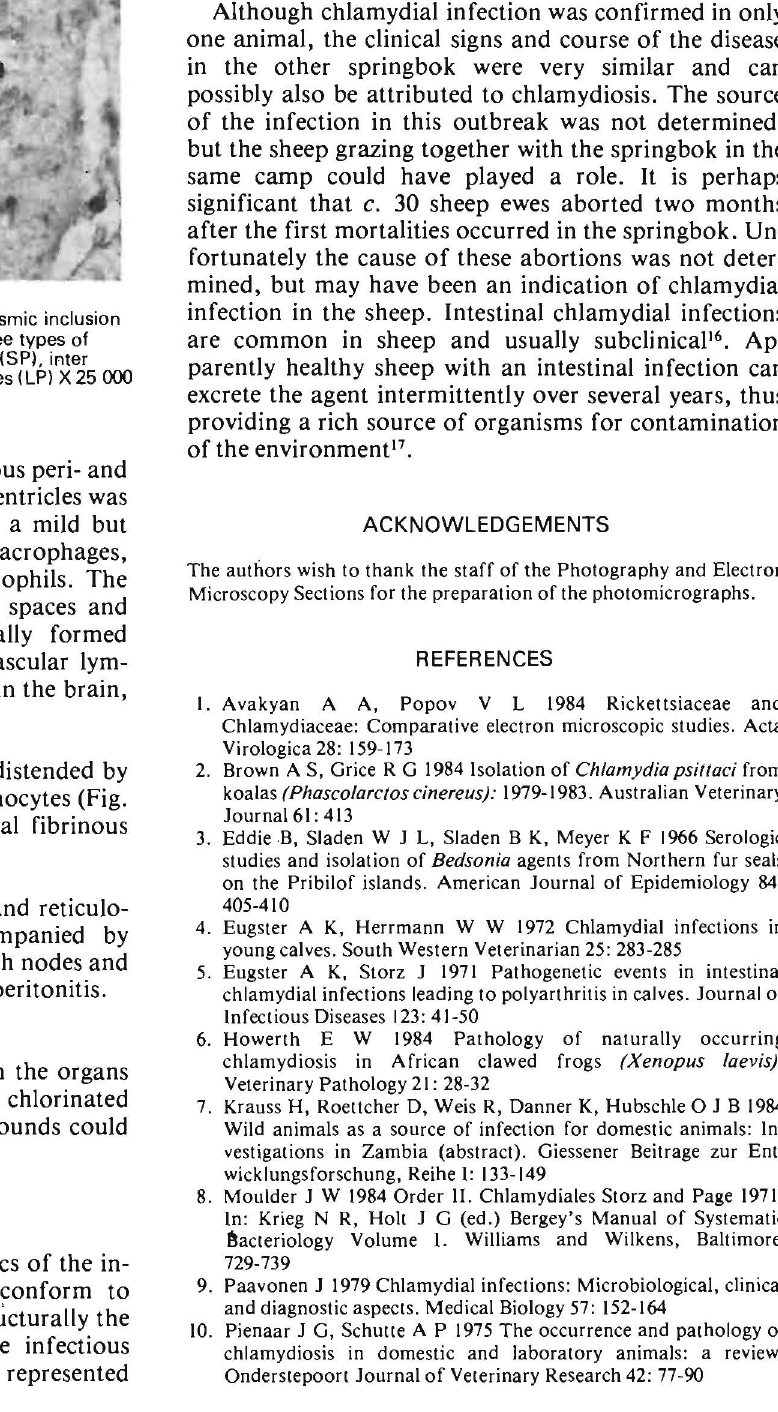
Fig. 9: Electron micrograph of part of an intracytoplasmic inclusion in a mononuclear cell in the renal cortex. Three types of particles are discernable: small dense particles (SPl, inter mediate particles (lP) and large granular particles (LP) X 25000